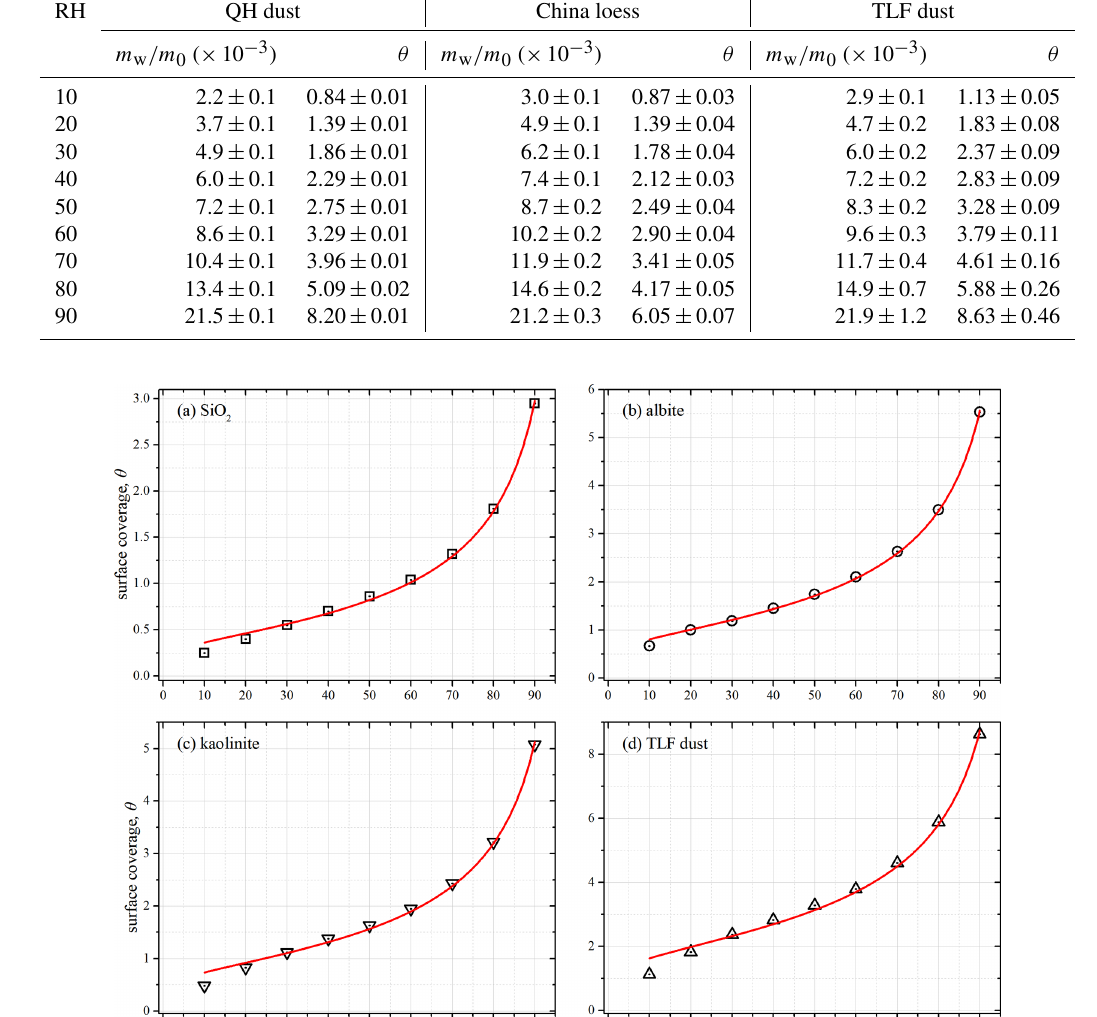
dust samples examined ( R 2 values were found to be in the range of 0.94–0.99), and the generated A FHH and B FHH